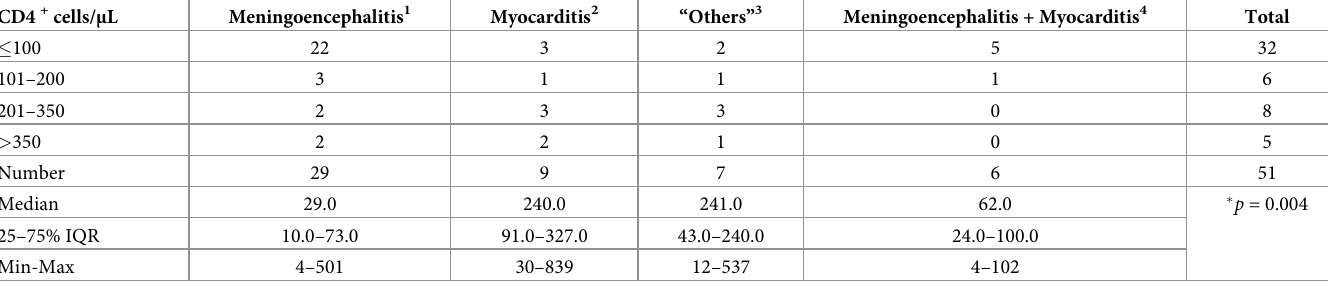
Table 4. Distribution of patients according to category of CD4 + cells/ μ L and site of Chagas disease